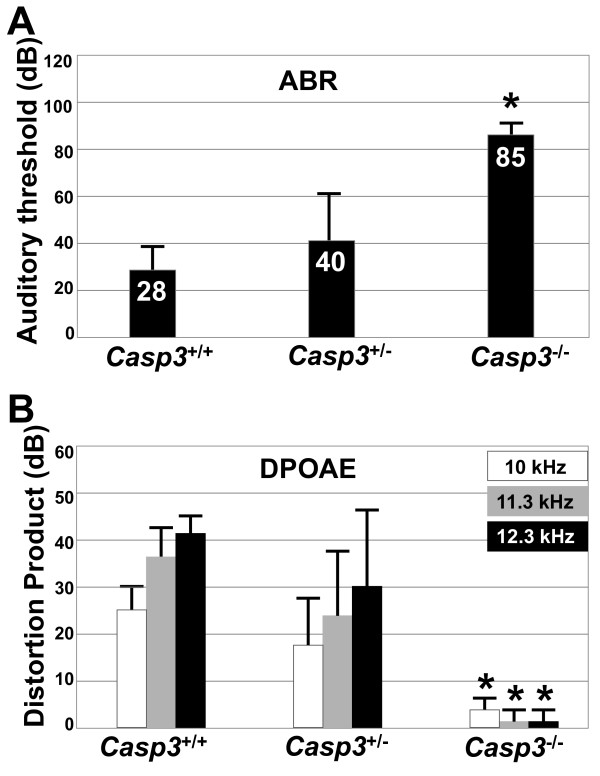
Auditory dysfunction in caspase-3 deficient mice. (A) Auditory brainstem response (ABR) thresholds to click stimuli at 3 months of age. Casp3-/- (n = 6) mice had a significantly higher threshold (*, P < 0.05) compared to Casp3+/- (n = 13) and Casp3+/+ (n = 5) mice. (B) Distortion product otoacoustic emission (DPOAE). Averages of distortion product 2F1-F2 at F2 frequencies of 10 kHz, 11.3 kHz, and 12.3 kHz were compared at 3 months of age. Casp3-/- (n = 5) mice had a significantly smaller distortion product (*, P < 0.05) compared to Casp3+/- (n = 9) and Casp3+/+ (n = 5) mice.